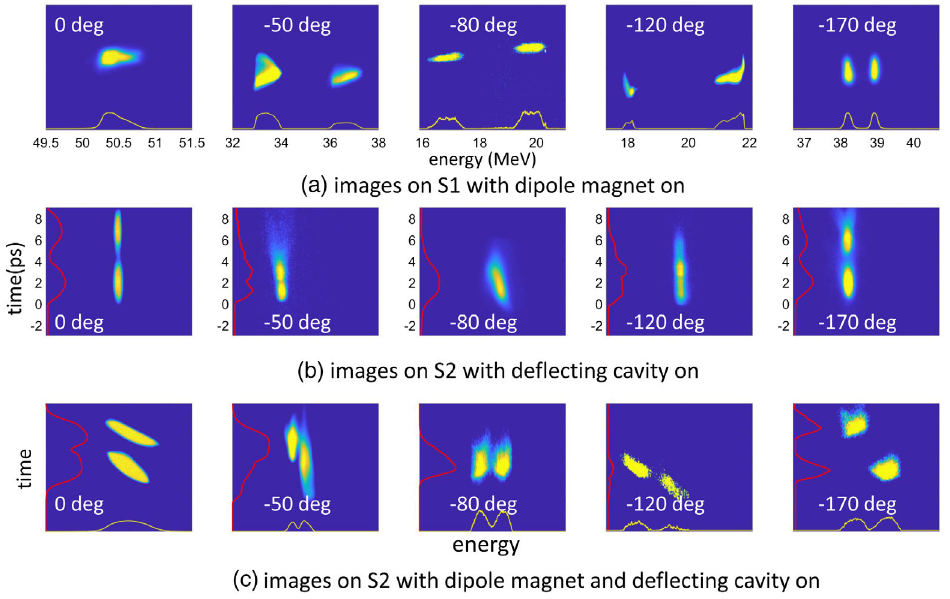
FIG. 7. Experimental images used to measure the beam ’ s energy and time spaces with different TWA phases: maximum acceleration when the phase ¼ 0 degrees, under-compression mode when the phase ¼ − 50 degrees, full-compression mode when the phase ¼ − 80 degrees, and deep over-compression modes when the phase ¼ − 120 degrees and the phase ¼ − 170